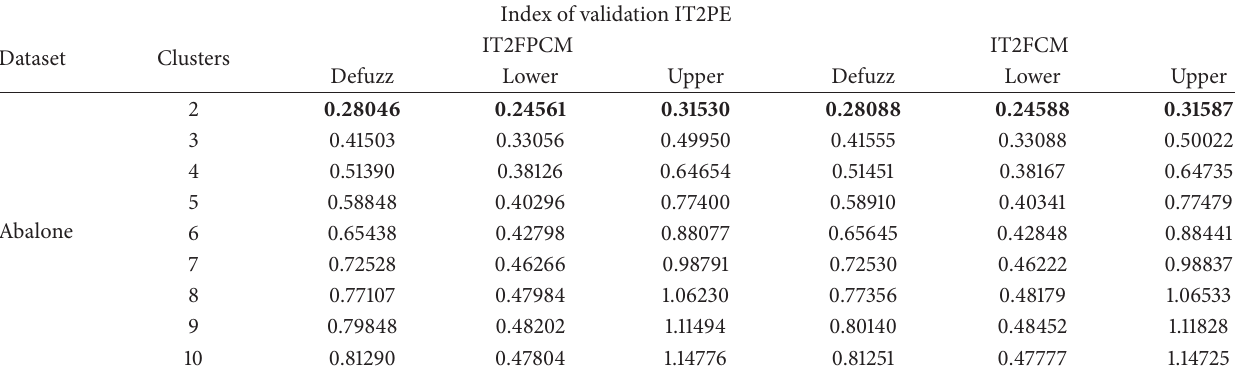
Table 18: Results of the IT2PE validation index to Abalone dataset clustering using IT2FPCM and IT2FCM algorithm with 𝑚 = [1.5, 2.5] and 𝜂 = [1.5, 2.5] as